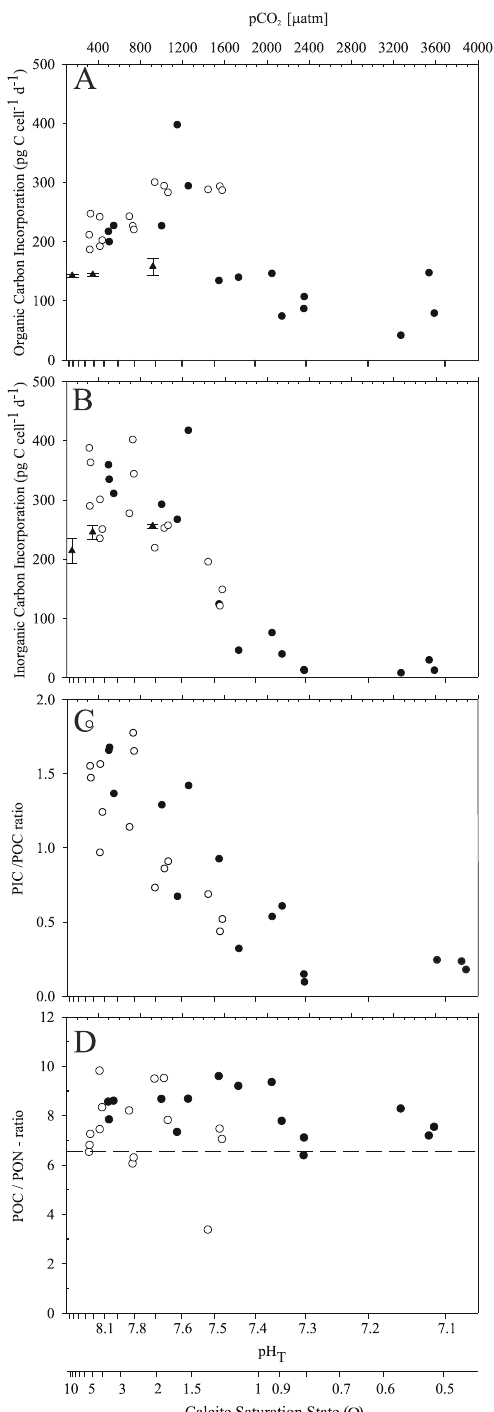
Fig. 1. Particulate organic and inorganic carbon production rates – (A) and (B) , respectively – together with ratios of particulate in- organic to organic carbon (C) and particulate organic carbon to ni- trogen (D) in response to changes in carbon chemistry speciation. Filled circles represent results of the first and open circles of the second experiment, while triangles those of Langer et al. (2006) for comparison.